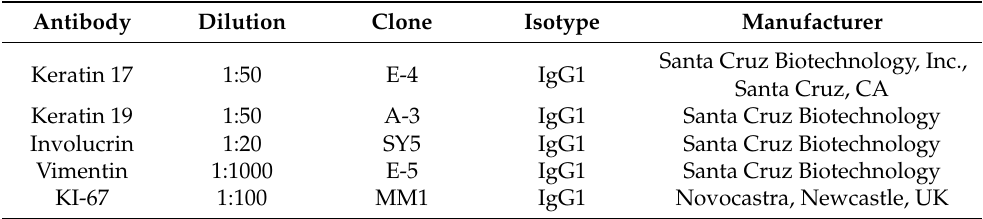
Table 3. Primary Antibodies Used for Immunohistochemical